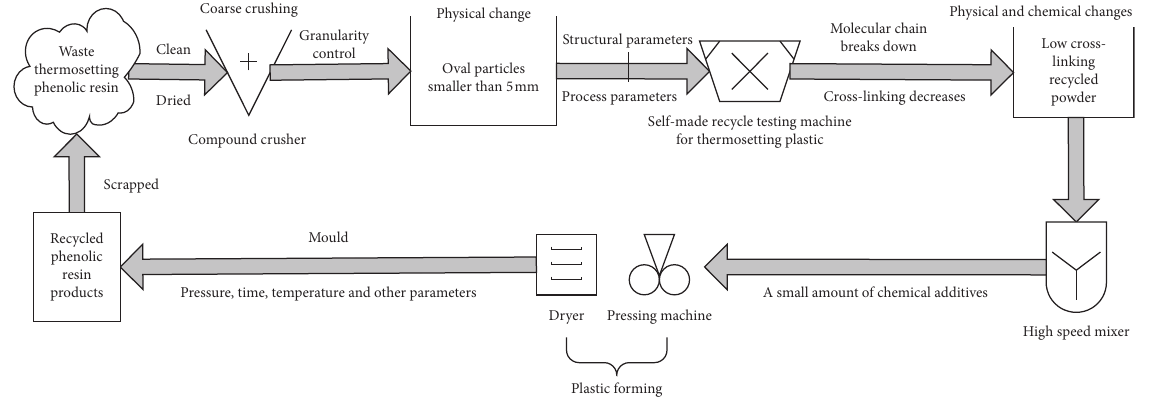
Figure 1: Closed-loop recovery process of thermosetting phenolic